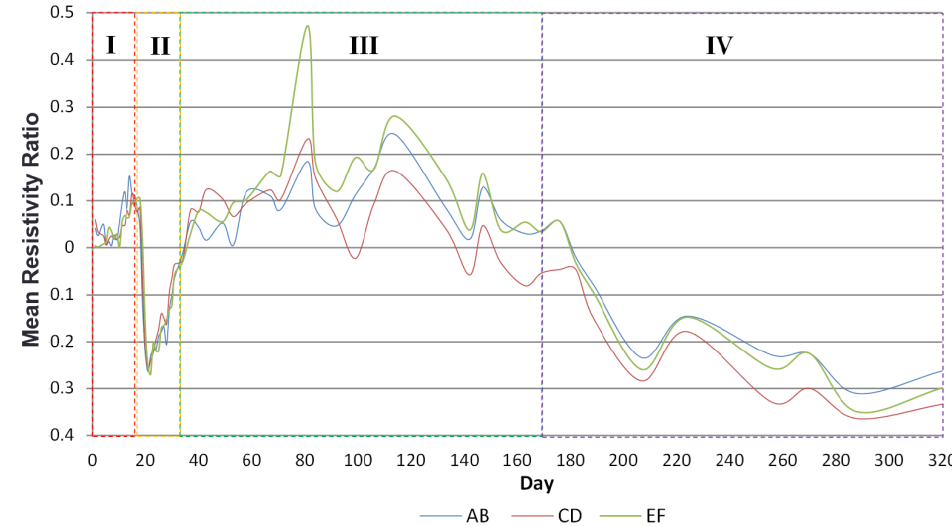
Figure 7. Temporal distribution of resistivity maps mean value recorded between the built-up boreholes with individuation of the hypothesized